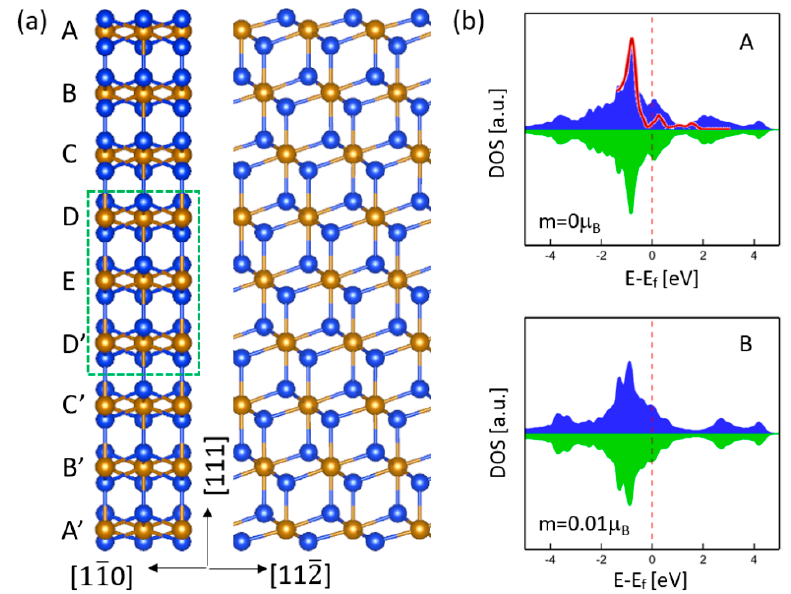
Figure 2. ( a ) Atomic structure of free-standing γ -FeSi 2 (111) nanoslabs with nine Fe layers. ( b ) DOS of Fe atoms in the first two Fe layers (A and B) near the surface and the corresponding calculated spin moments. The red curve is an experimental DOS reproduced from [17].